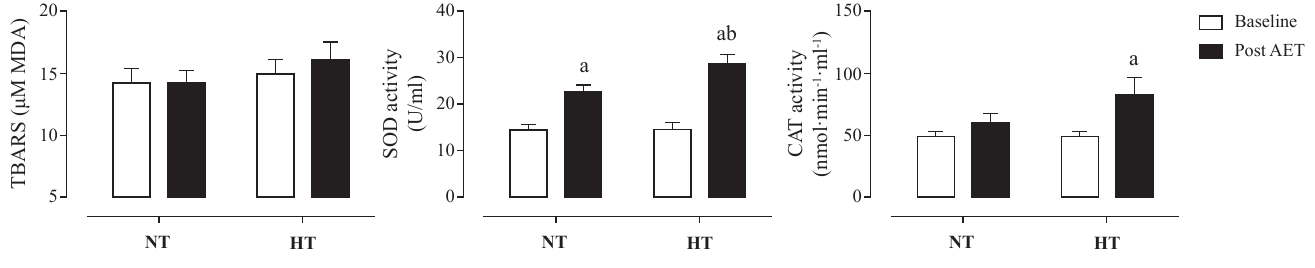
Figure 3. Fasting redox state in normotensive and hypertensive postmenopausal women at baseline and post aerobic exercise training.